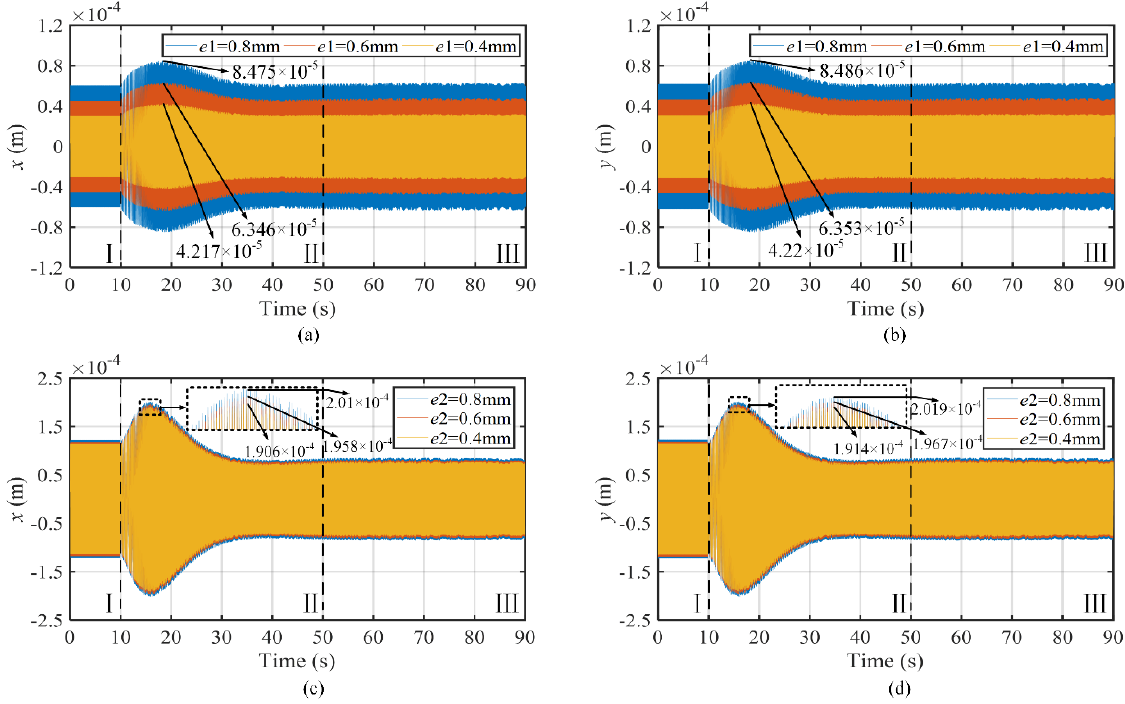
Figure 14. The time-domain figure of and under different mass eccentricities. ( a , b ) Generator rotor; ( c , d ) hydro-turbine runner.